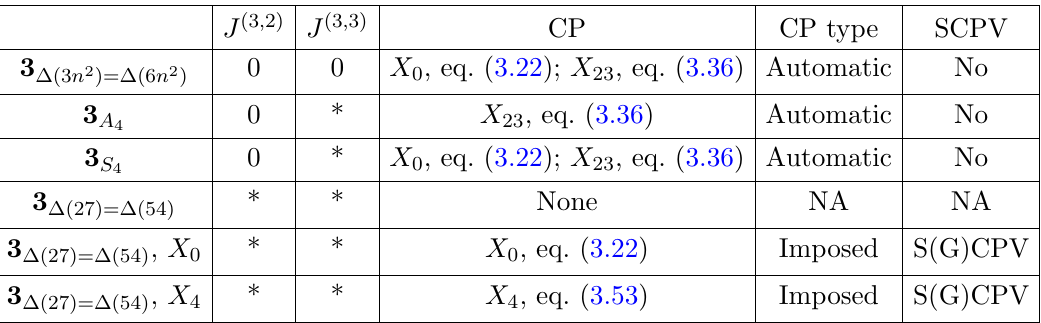
Table 6 . Summary of the value of J (3 ; 2) , J (3 ; 3) , CP symmetry transformations and whether SCPV is possible, for the 1 triplet scalar potentials analysed. The (cid:3) denotes that a SCPI is non-zero for arbitrary VEVs (it may still vanish for the potential’s VEVs), NA stands for Not Applicable (SCPV is not meaningful in cases without a CP symmetry).